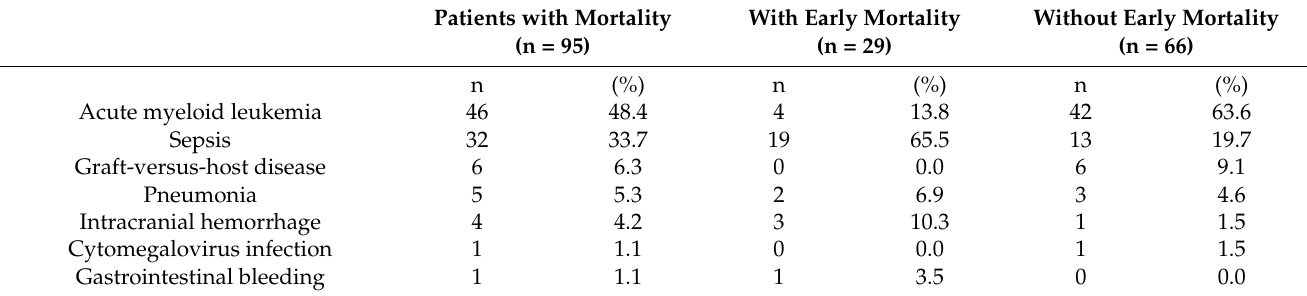
Table 3. Causes of